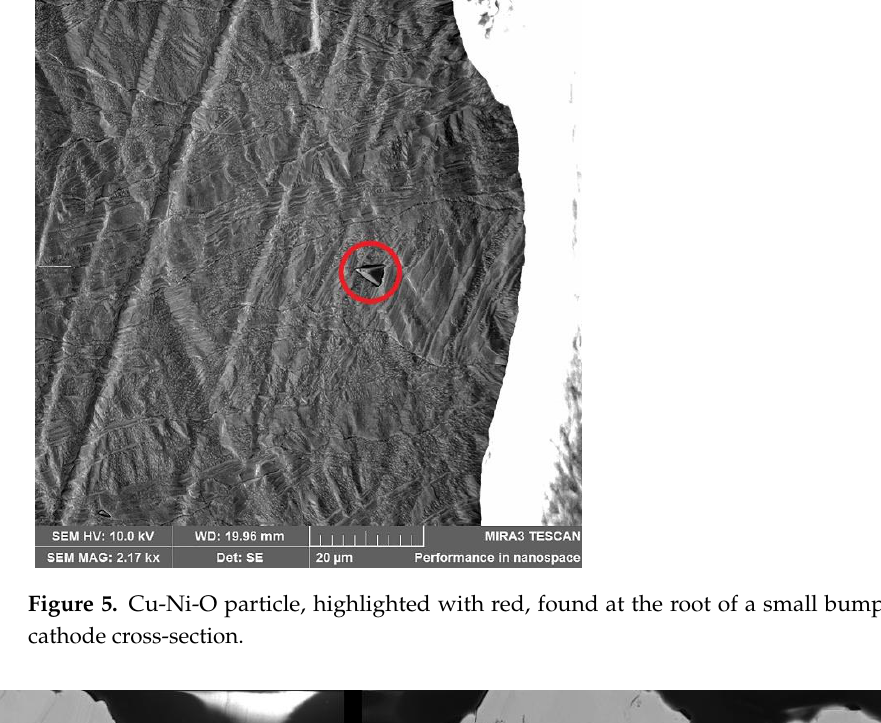
Figure 5. Cu-Ni-O particle, highlighted with red, found at the root of a small bump on the SB-4 cathode cross-section.